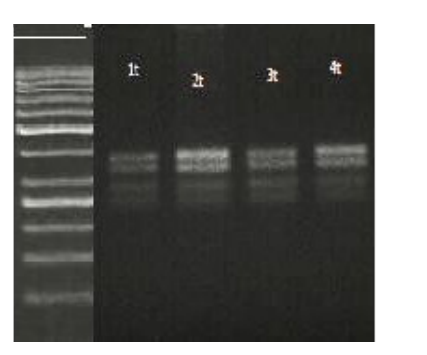
Table 1. Descriptive statistics of the demographic and laboratory data in bladder cancer patients (group 1), pathological controls (group 2)